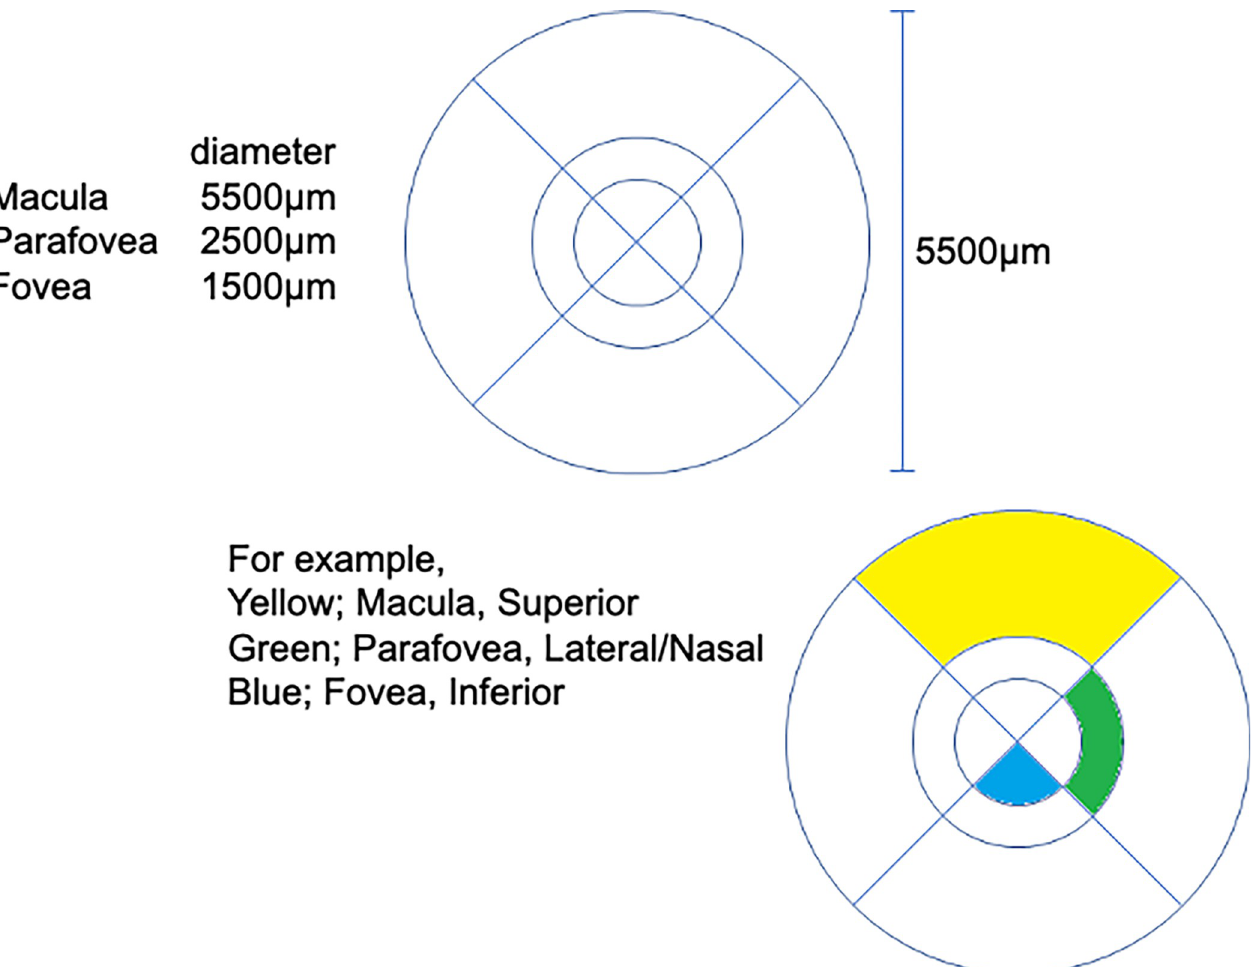
(Fig 2). On the number of MAs in each area, the inter-rater agreement of the measurers on FA, IA and OCTA were 0.407025, 0.540321, 0.254121, respectively. Regardless of the